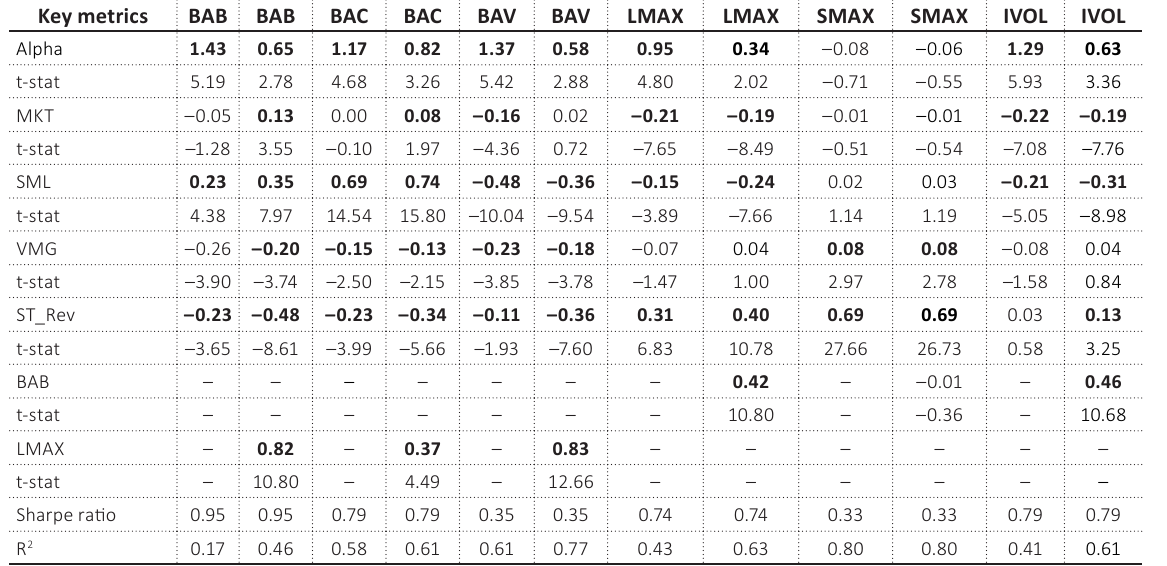
Table C1 reports the regression results of all factors constructed using a rank-weighted methodology. Alphas and Sharpe ratios are reported on monthly and annualized basis, respectively. t-statistics are shown below the coefficient